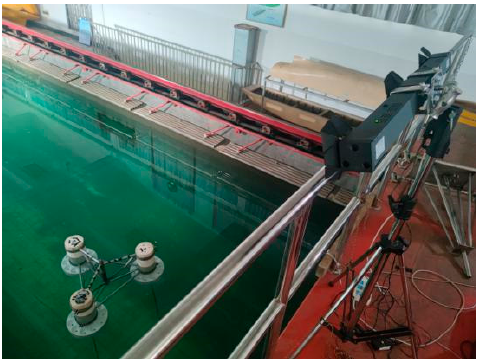
Figure 9. Installation of PTI 3D motion capture system on Trailer.